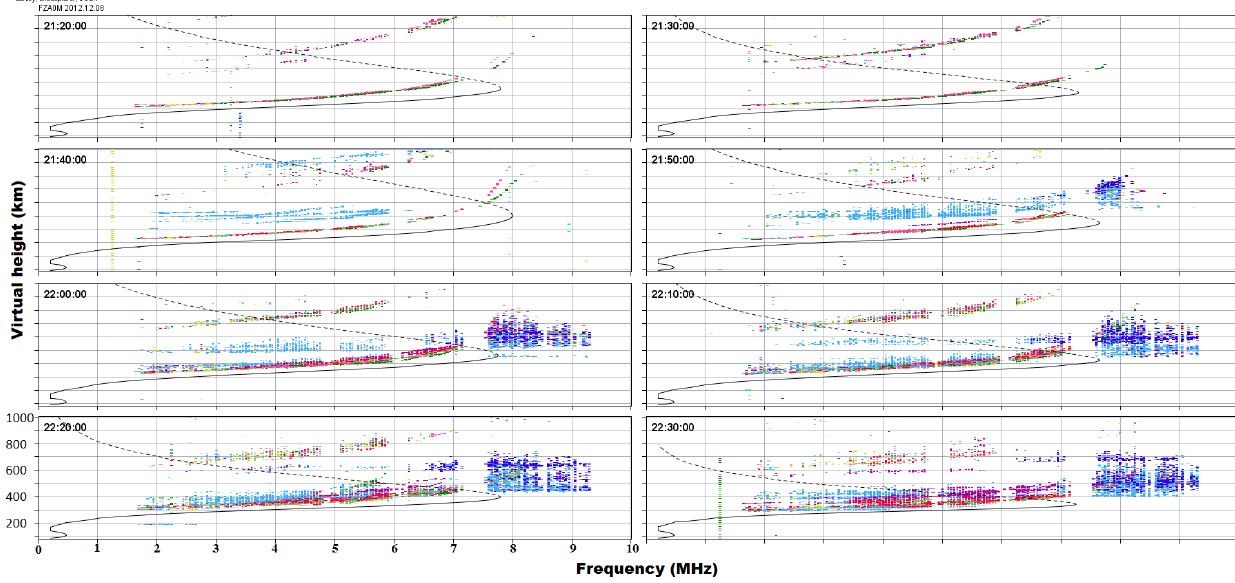
Figure 3. Sequence of ionograms taken on 8 December 2012 (18:20–19:30LT) at Fortaleza. Spread F begins around 19:30LT.